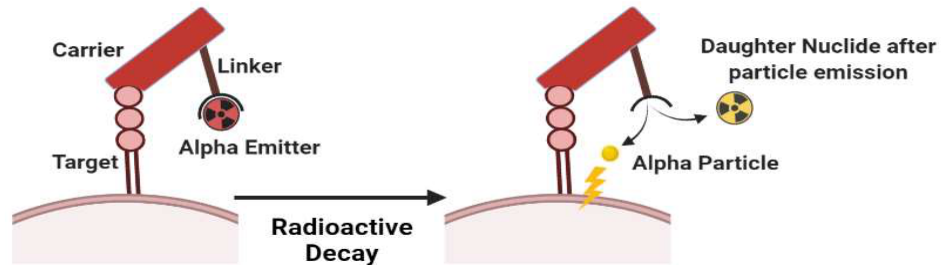
Figure 3. Scheme of complex instability of alpha emitter due to recoil energy effect.